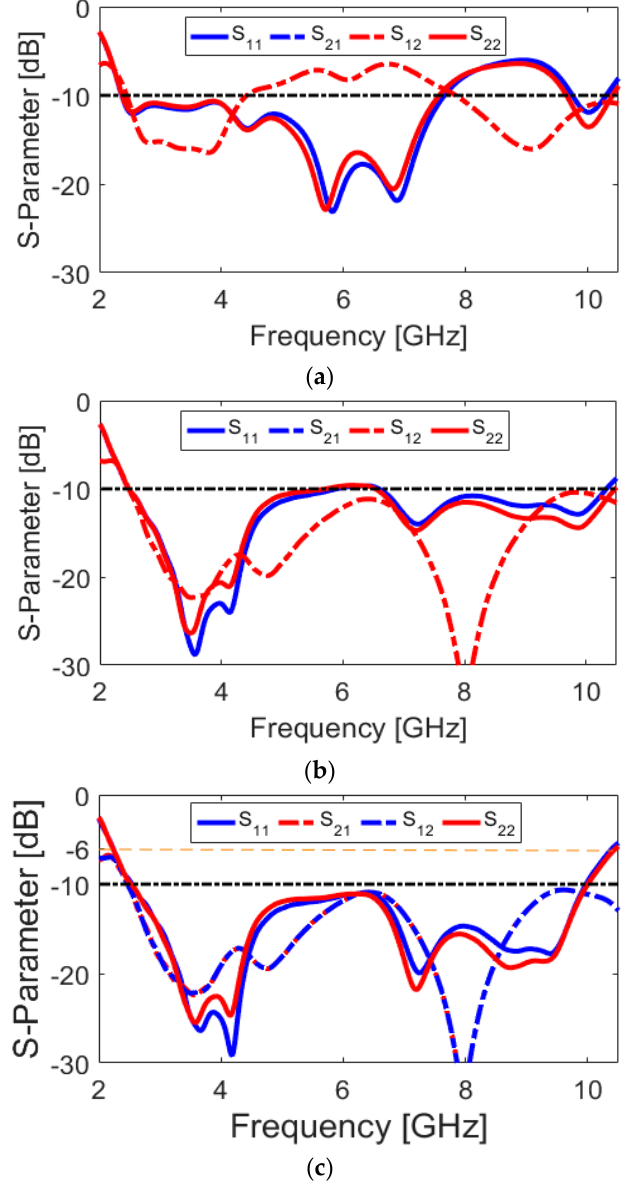
Figure 3. S parameters of the ( a ) antenna with a circular-ring slot radiator, ( b ) the antenna with open-ended circular-ring slot, and ( c ) the proposed UWB antenna